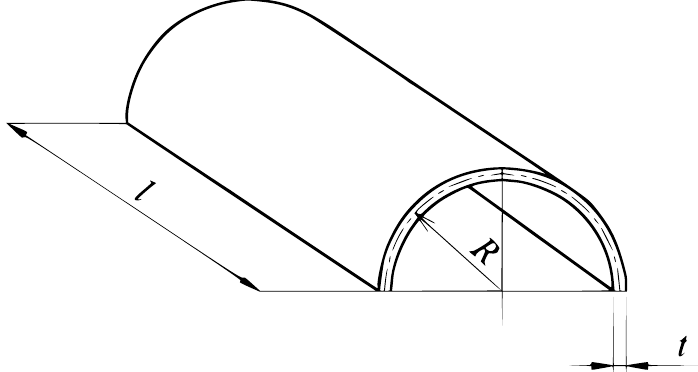
Figure 6. The domain of the bending-dominated piezoelectric half-cylindrical shell.